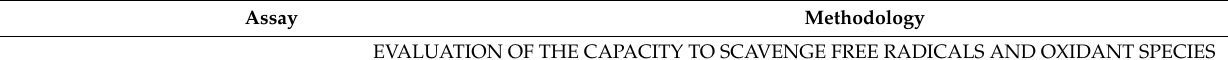
Table 3. Assays employed for the evaluation of antioxidant activity. Assay Methodology Refs. EVALUATION OF THE CAPACITY TO SCAVENGE FREE RADICALS AND OXIDANT SPECIES Measurement of the reduction in the absorbance of a H 2 O 2 solution at 230 nm after incubation with potential antioxidants.